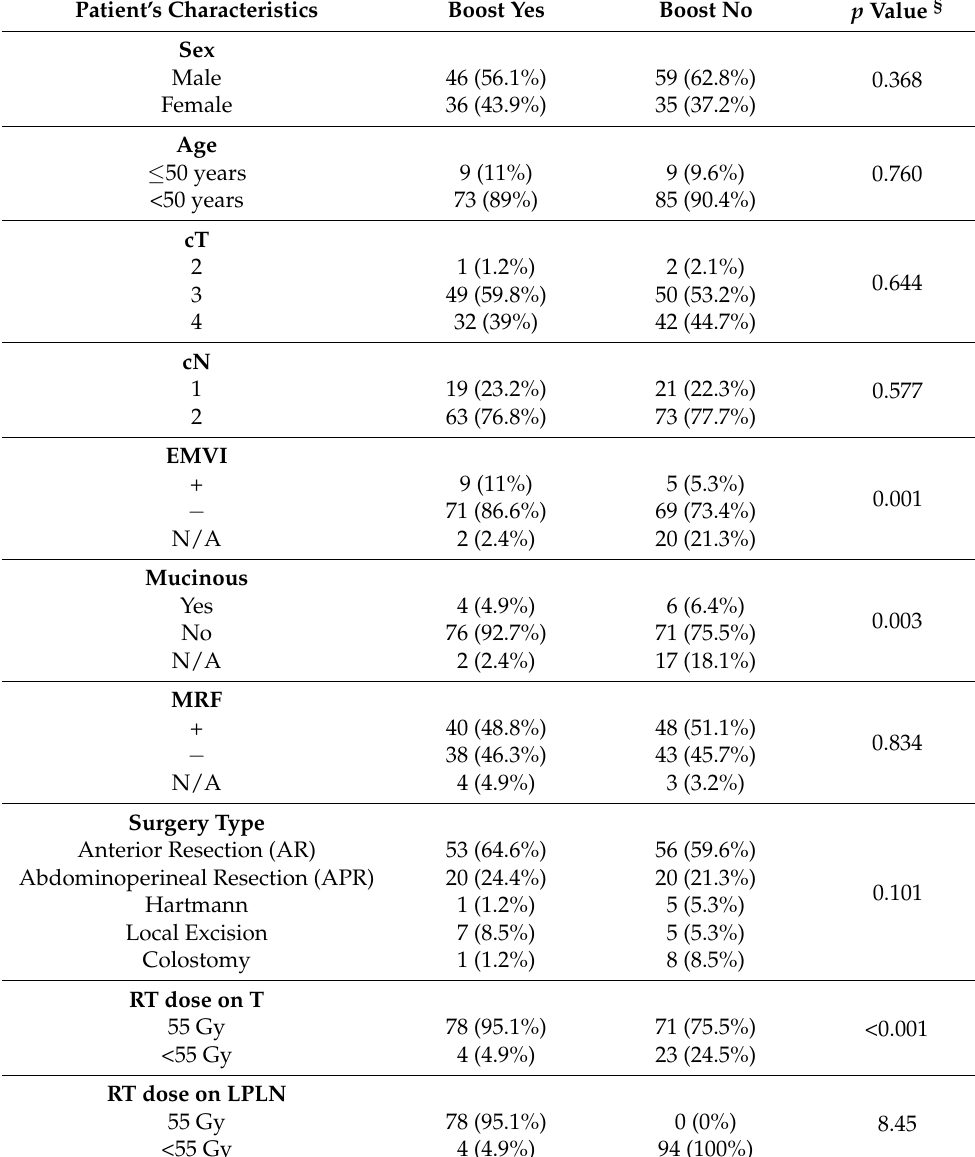
Table 2. Patients’ characteristics divided by RT boost’s